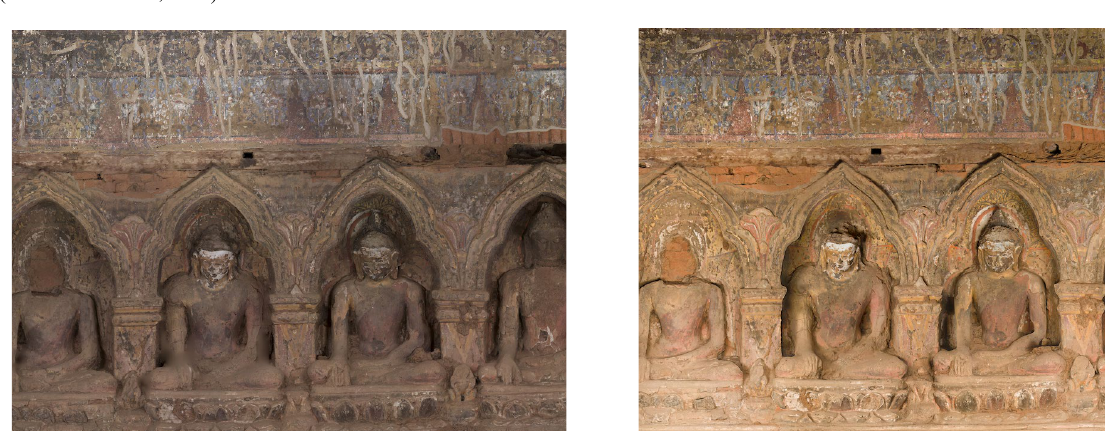
Figure 5. The 2018 orthophoto of the East inner wall in Myin- pya-gu. Areas of the image are out of focus and unevenly lit with shadows in the Buddha niches (Credit: © Carleton Immersive Media Studio; Carleton University).